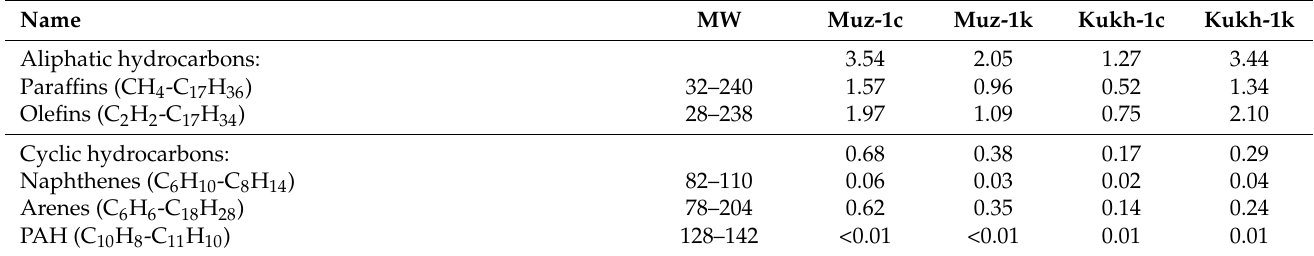
Table 3. Composition of volatile components released during mechanical destruction of cordierite from the Muzkol metamorphic complex (Muz-1) and from pegmatite of the Kukhilal deposit (Kukh-1), Tajikistan [96], according to GC-MS analysis